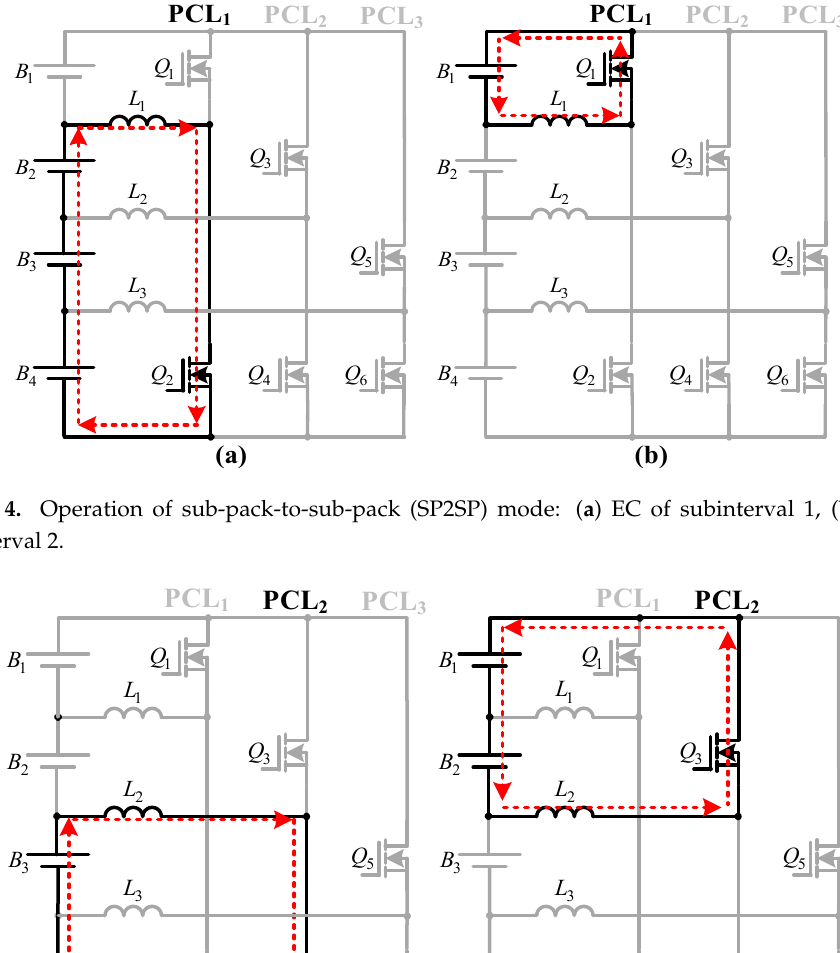
Figure 3. Operation of cell-to-sub-pack (C2SP) mode: ( a ) equivalent circuit (EC) of subinterval 1, ( b ) EC of subinterval 2.